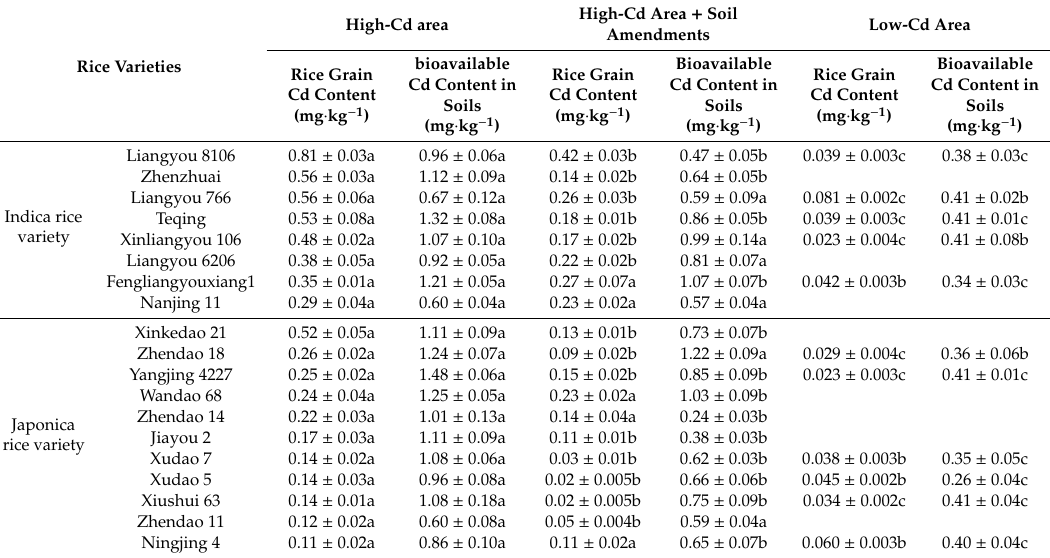
Table 2. Cd content in rice grains and bioavailable Cd content in soils with di ff erent treatments. High-Cd Area + Soil High-Cd area Rice Varieties